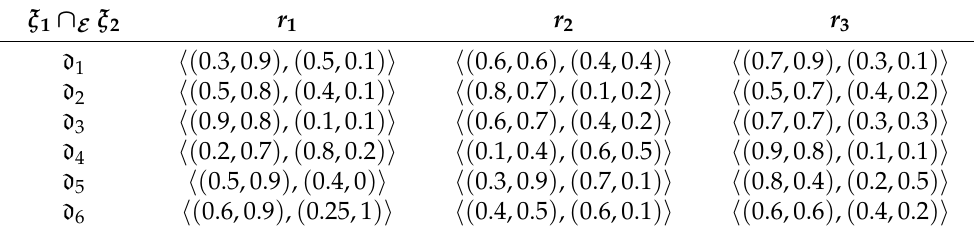
Table 12. Table for the extended intersection ξ 1 ∩ E ξ 2 . ξ 1 ∩ E ξ 2